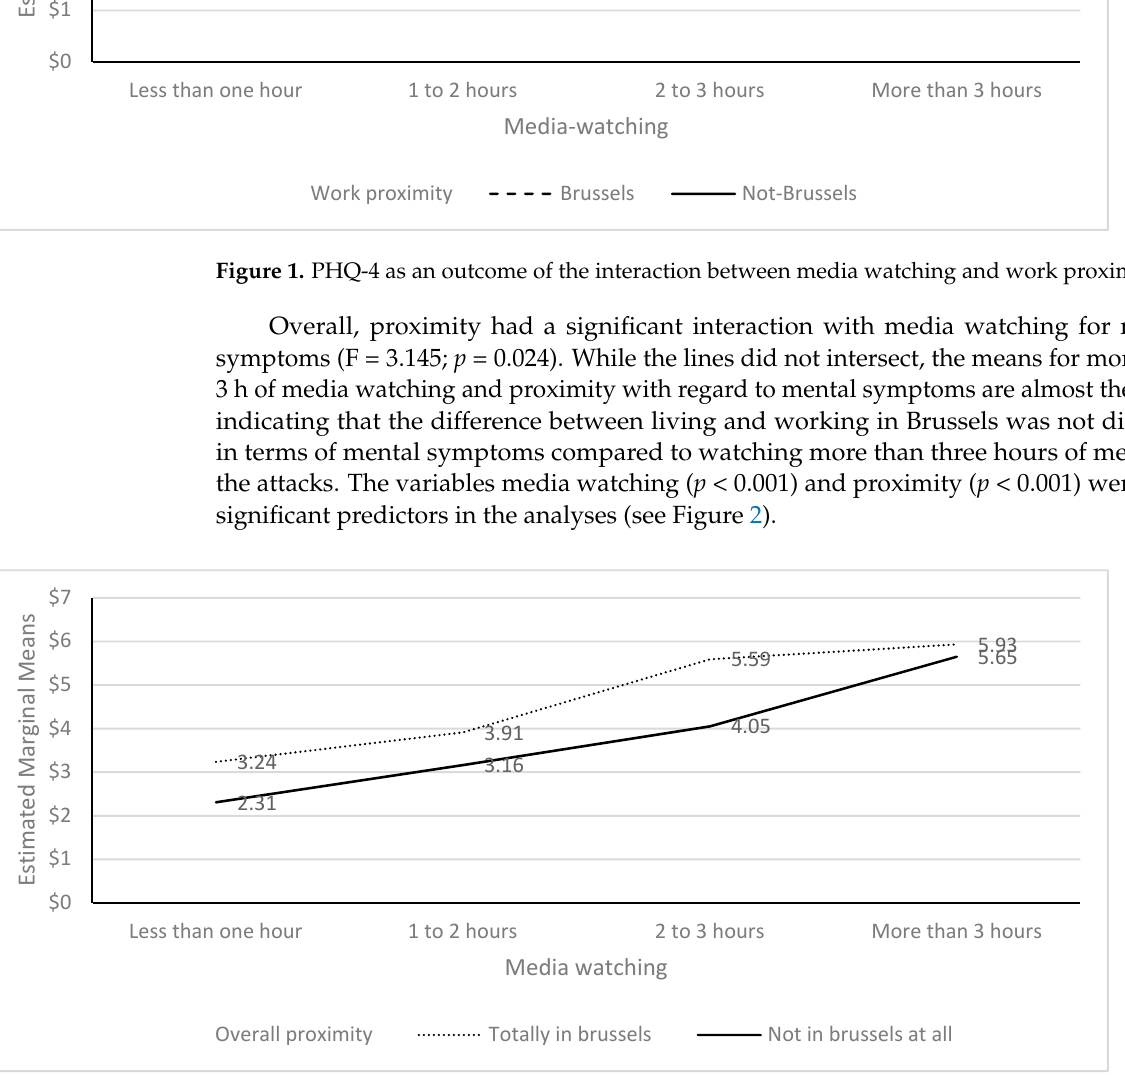
Figure 2. PHQ-4 as outcome for media watching and overall proximity. For somatic symptoms, there was no interaction effect for home proximity and media watching (F = 1.396; p = 0.242). Home proximity was not significant (F = 2.640; p = 0.104), and media watching was (F = 46.918; p < 0.001). For neither work proximity nor media- watching was there an interaction effect (F = 1.369; p = 0.250). Here, work proximity was not significant (F = 2.935; p = 0.087), while media watching was (F = 63.310; p < 0.001). Overall, proximity had no interaction effect with media (F = 1.609; p = 0.185). Media watching was significant (F = 35.615; p < 0.001) and proximity as well (F = 3.874; p = 0.049).